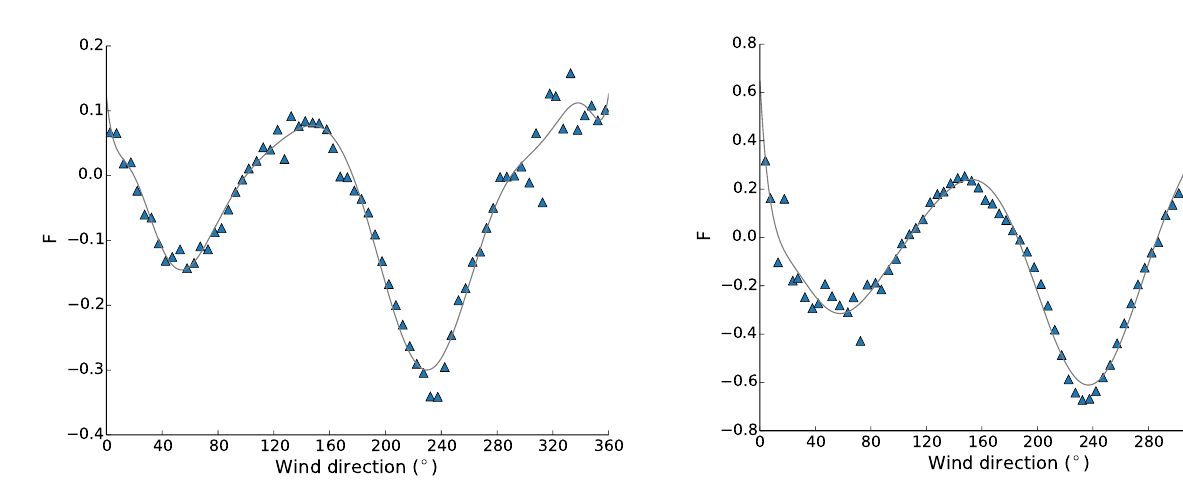
Figure 7. Calibration function F 3 for velocity class 3.